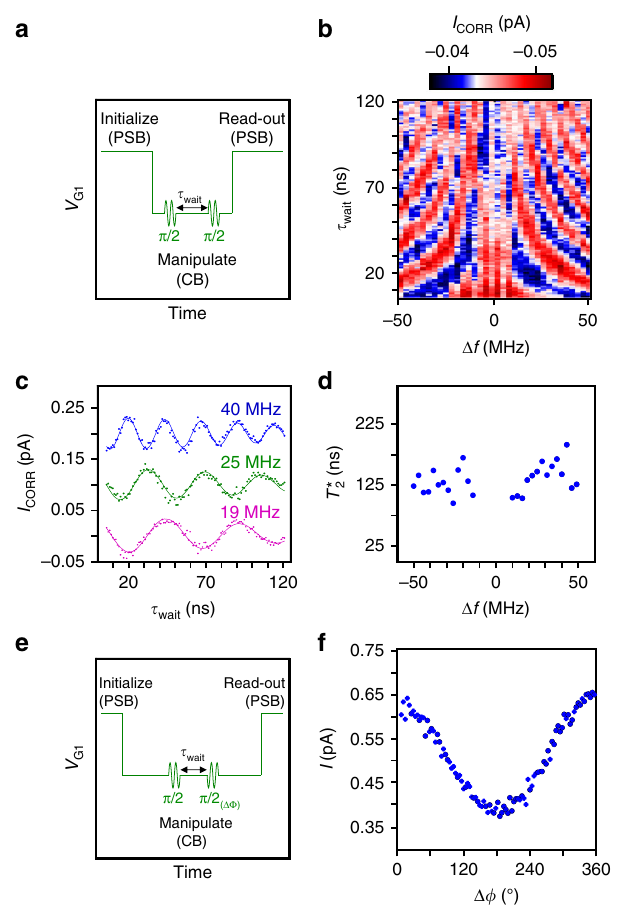
Fig. 6 Two-axis qubit control. a Voltage signal applied to G1 for inducing Ramsey oscillations caused by the frequency detuning Δ f between the Larmor and the RF burst frequency. The square pulse shifts the qubit between PSB (210 ns) and CB (160ns). Each of the two RF bursts having the same phase are separated by the waiting time τ wait and rotate the spin vector for a π angle. b I CORR versus τ wait and Δ f for P = 11 dBm and τ burst = 2 3.5 ns in presence of an out-of-plane magnetic fi eld of 127 mT and at a center frequency of 5.966 GHz. c Line traces from b for Δ f = 19, 25 and 40 MHz. The traces for 25 and 40 MHz are shifted by 100 and 200 fA, respectively. d Plot showing the extracted dephasing times for various (cid:3)ð τ wait Þ 2 T (cid:1) 2 values of Δ f . The times were extracted by fi tting the data to Ae sin (2 π Δ f τ + ϕ ) + offset. The average dephasing time exceeds 130 ns. e wait Voltage signal applied to G1 for performing a two-axis qubit rotation caused by Δ ϕ between the two RF bursts . The manipulation interval lasted for 160 ns, while the read-out and the initialization lasted for 30 ns each. f Current passing through the DQD versus Δ ϕ . The oscillatory behavior of the current demonstrates the qubit rotation around the axis de fi ned by Δ ϕ . For this experiment the following parameters were chosen: P = 4 dBm, τ = 9 ns, τ = 10 ns, f = 5.887 GHz and an out-of-plane magnetic fi eld burst wait of 122 Table 1. The wafers were dipped in an HF solution before loading into the MBE chamber. After degassing at 720 °C, a Si buffer layer was deposited. Then 6.7Å (6.5 Å) of Ge were deposited on the substrate at 580 °C (545°C) followed by an in- situ annealing of 5h (4 h) at 570°C (535°C) for device A and C (device B). The amount of the deposited Ge is at the critical thickness for the nucleation of three dimensional hut clusters. At last, the substrate temperature was decreased to 300 °C and capped with 5nm (3 nm) Si for device A and C (device B). Device A and C (device B) were fabricated using a 100 kV (20 kV) e-beam lithography system. For the source and drain contacts 25 nm Pt (5/25 nm Pd/Al) were deposited. The gates (3/25nm Ti/Pt) were evaporated onto an about 6 – 8nm hafnium oxide layer. The oxide was created by atomic layer deposition of 80 cycles